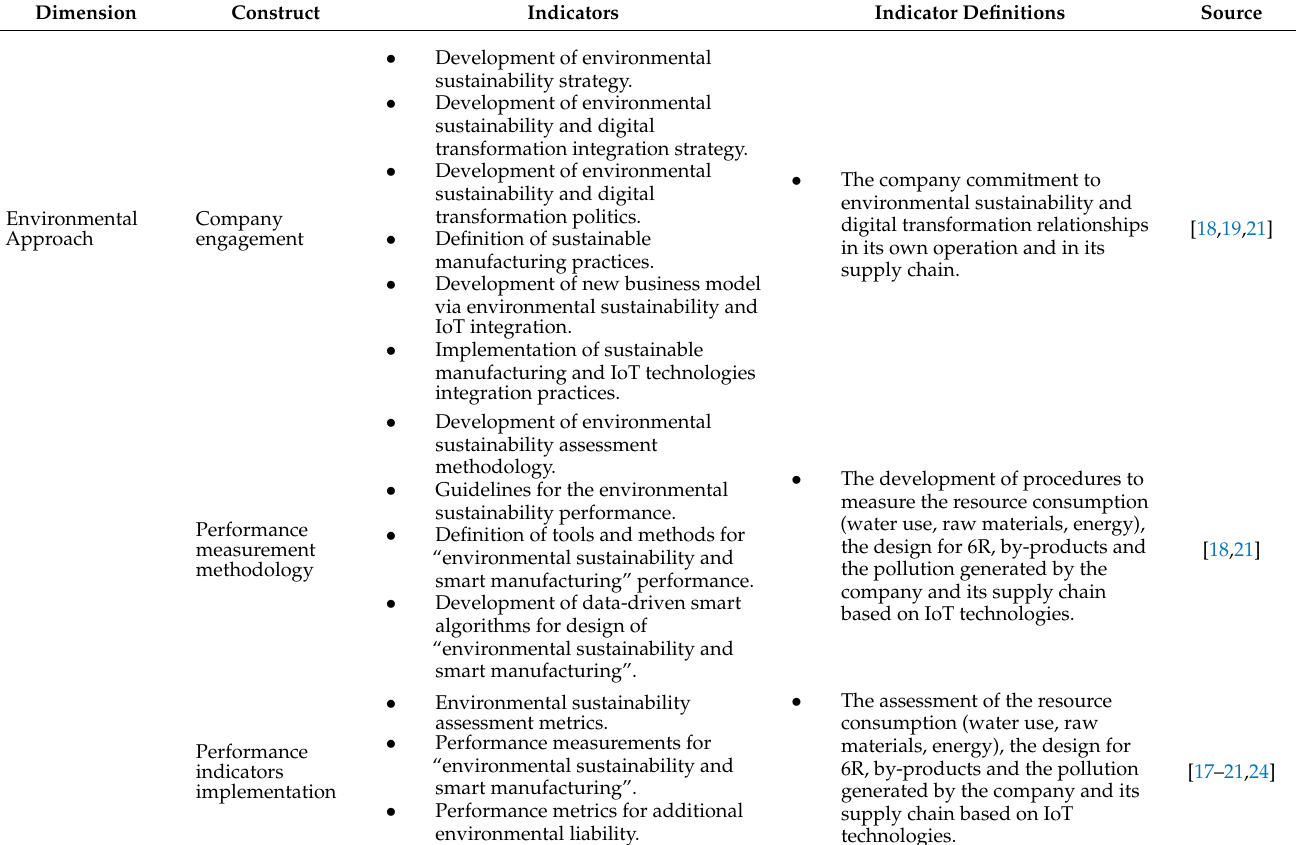
Table 2. Environmental